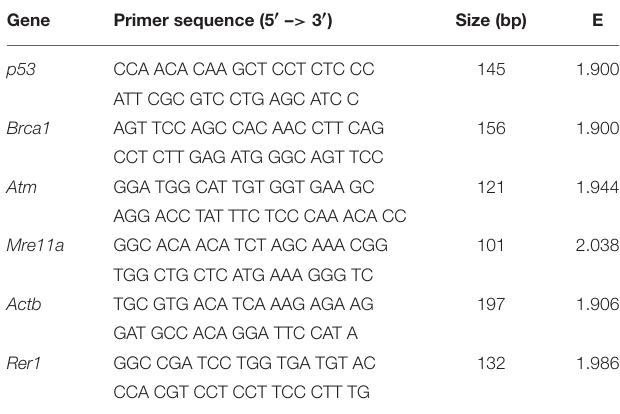
TABLE 1 | qPCR primer